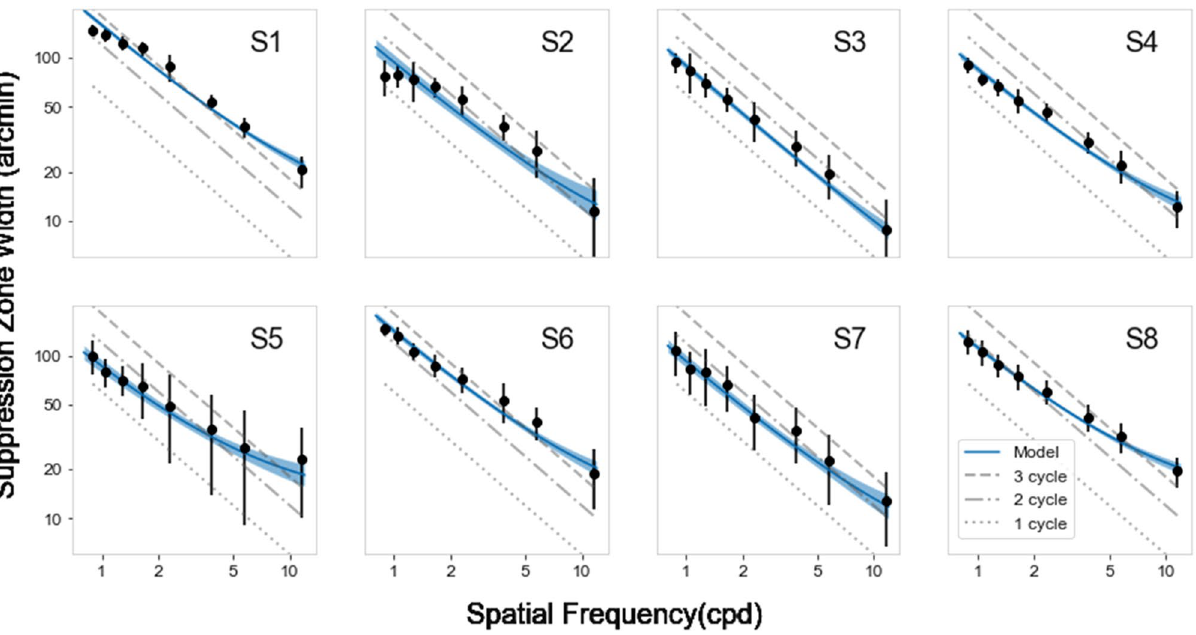
Figure 5. The model predicts the individual results well, indicated by the shaded blue region, indicating 95% credible intervals from the fits. Different dashed lines indicate the multiplication of the number of full